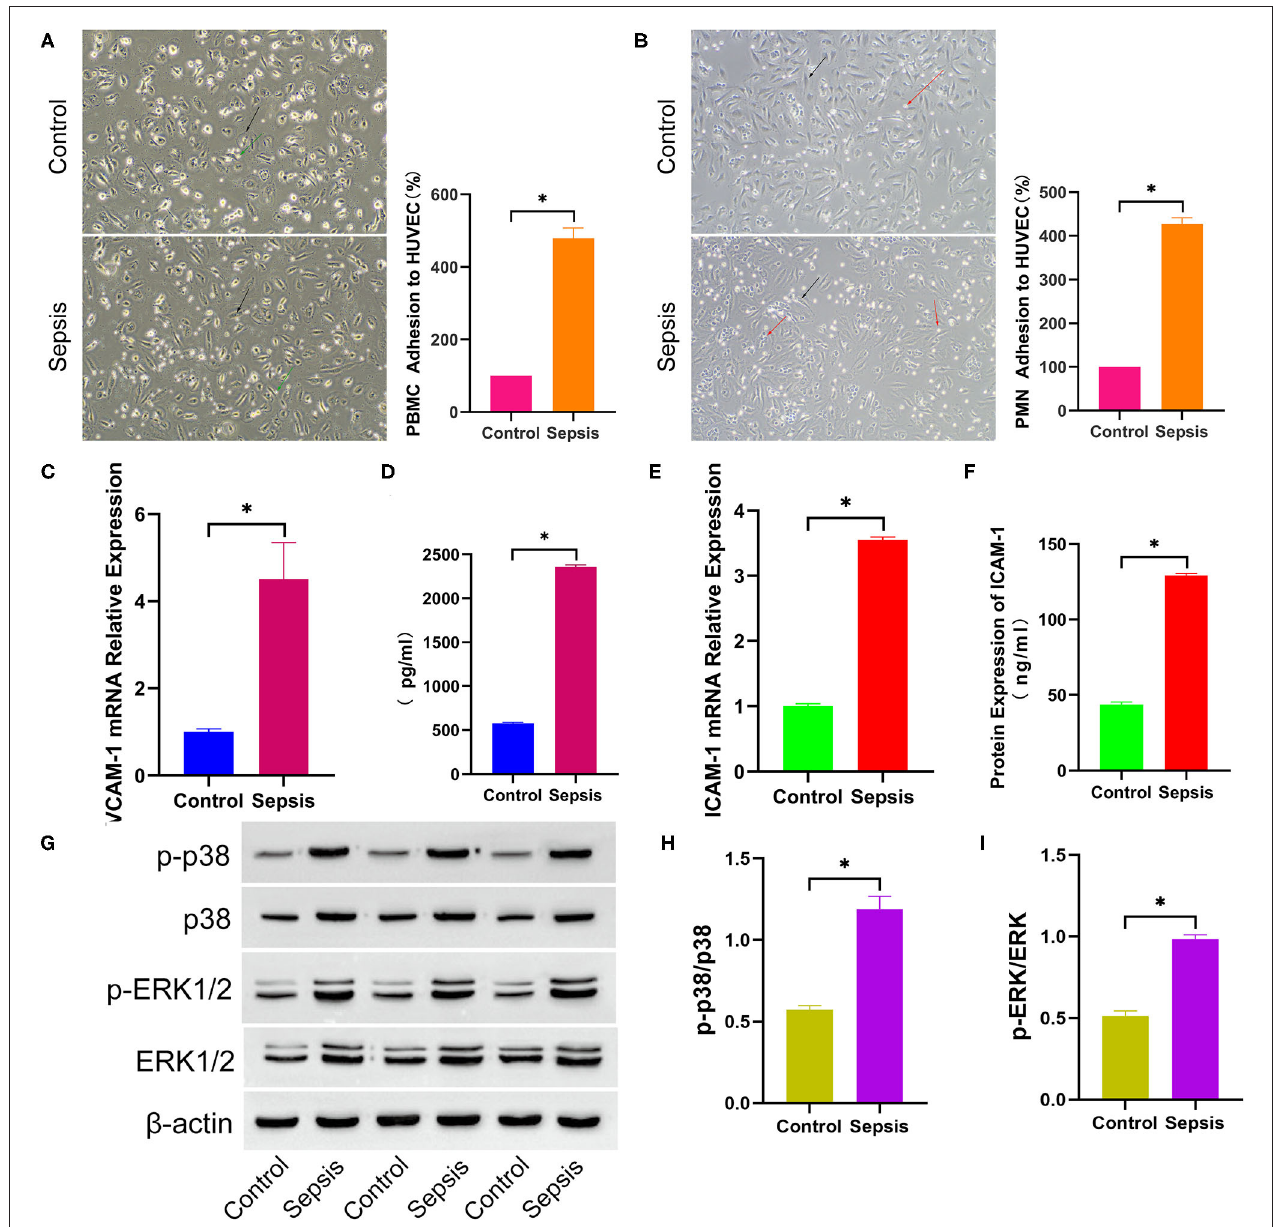
FIGURE 4 | Sepsis serum promotes leukocyte adhesion to HUVEC. After incubated with differently treated HUVEC for 2h, PBMC (A) and PMN (B) adhesion to HUVEC were shown in the bright field picture and measured by calculating the difference of cell counts between incubated leukocyte and washed leukocyte. The black arrow indicates HUVEC, green arrow indicates PBMC, and red arrow indicates PMN. After HUVEC treated with sepsis serum and control serum for 6h separately, the mRNA expression of VCAM-1 (C) and ICAM-1 (E) were measured by q-RTPCR, and the protein level of VCAM-1 (D) and ICAM-1 (F) in supernatant were detected by ELISA. (G) The protein expression of total p38, p-p38, total ERK1/2, and p-ERK1/2 between sepsis group and control group was tested by western blotting assay. The relative gray value is shown in histogram (H,I) . * p < 0.05 between control and sepsis group by using t -test.